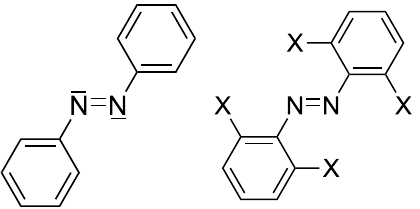
Figure 1. Left: azobenzene (AB); Right: basic structure of tetra- ortho -substituted azobenzenes. In both cases, the E isomer is